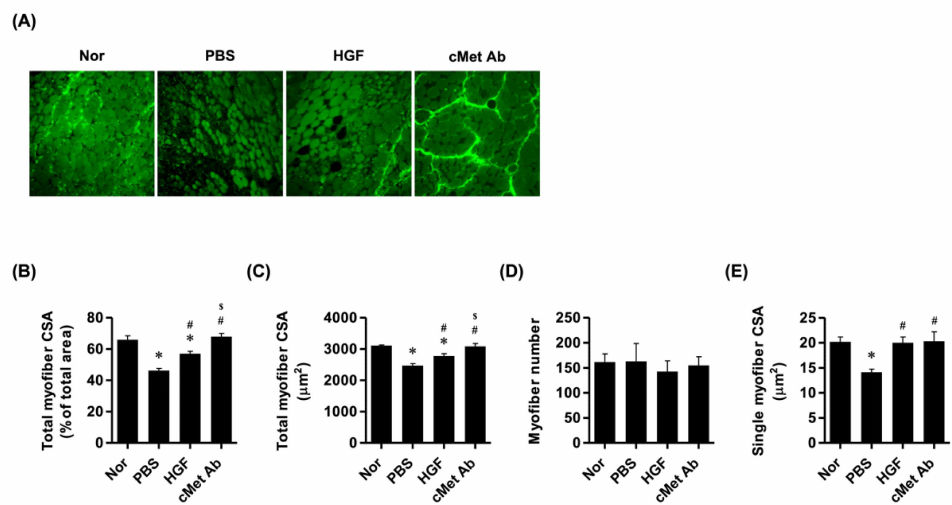
Figure 2. Histological evaluation of laryngeal muscles. ( A ) Representative images of myosin heavy- chain staining (original magnification: 200 × ). ( B , C ) Cross-sectional area of the total muscle fibers. ( D ) The number of muscle fibers was quantified by counting single muscle fibers. ( E ) Cross-sectional area of a single muscle fiber. * p < 0.05 compared to Nor (normal); # p < 0.05 compared to PBS; $ p < 0.05 compared to